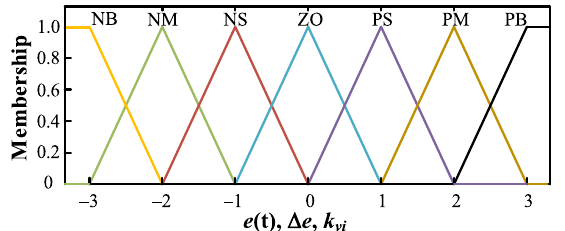
Fig. 17 Membership function of fuzzy